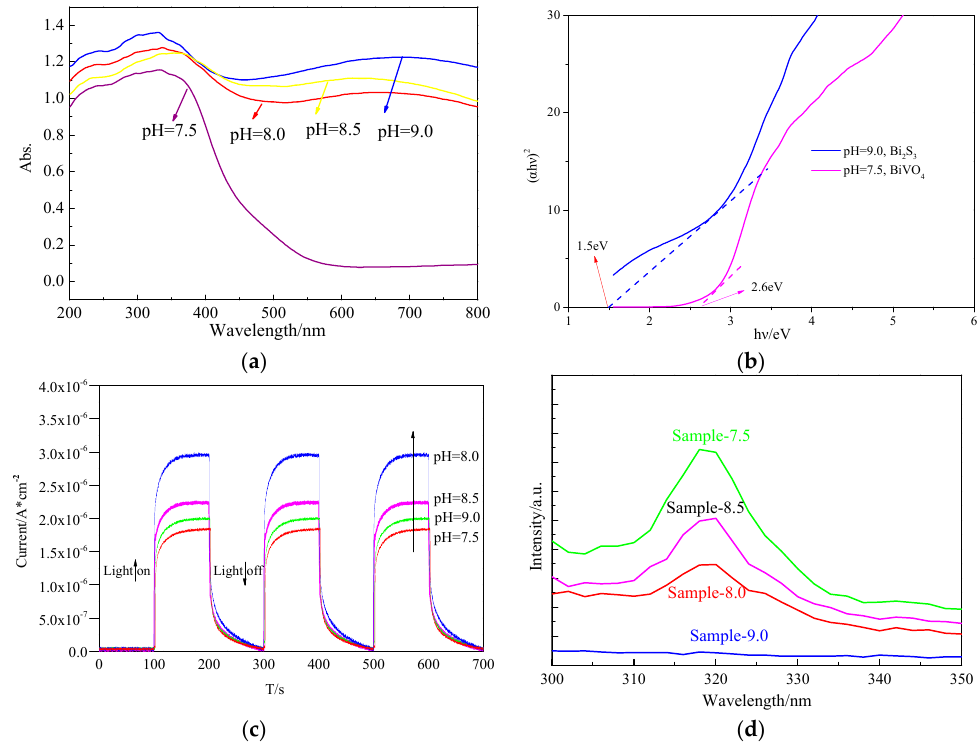
Figure 4. ( a ) UV-Vis diffuse reflectance spectra of samples; ( b ) Estimated band gaps of UV-Vis spectra of the samples; ( c ) Transient photocurrent response; ( d ) Photoluminescence (PL) spectra at an excitation wavelength of 280 nm.